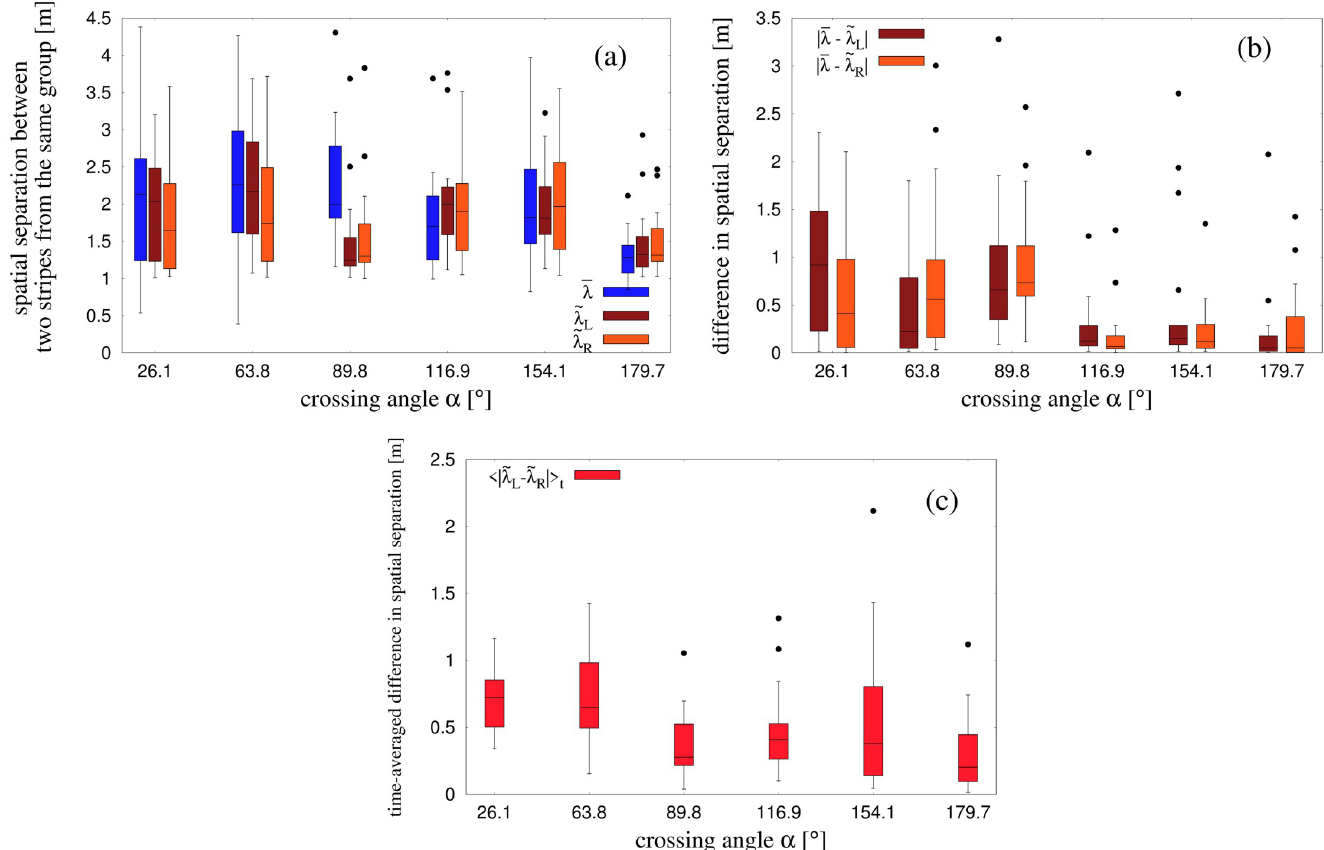
Fig 9. Boxplots for λ as estimated from the pattern matching technique. λ is the spatial separation between two alternate stripes from the same group. (a) The boxplots were made over all the trials for obtained values of � l , ~ l defined in Materials and methods. (b) Boxplots for the difference between obtained values of spatial separations from the whole-crowd and separate-group analyses under the pattern matching procedure. (c) Time-averaged difference of physical separation hj ~ l in a trial as estimated from the separate-group analysis using pattern matching technique.